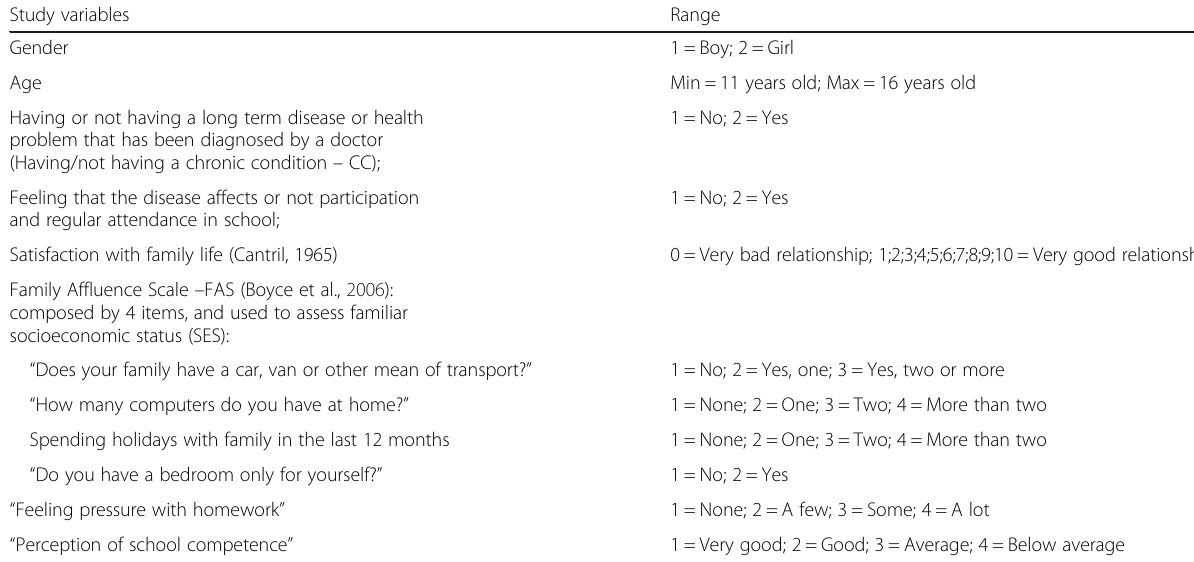
Table 1 Variables included in the study Study variables